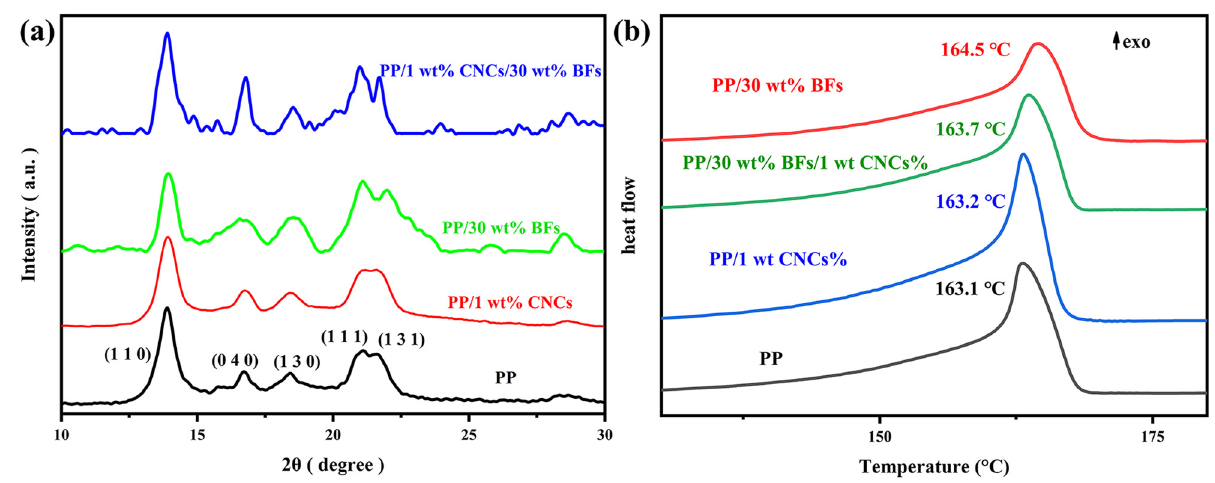
Figure 4: XRD spectra ( a ) and DCS curves ( b ) of composites with di ff erent component contents.